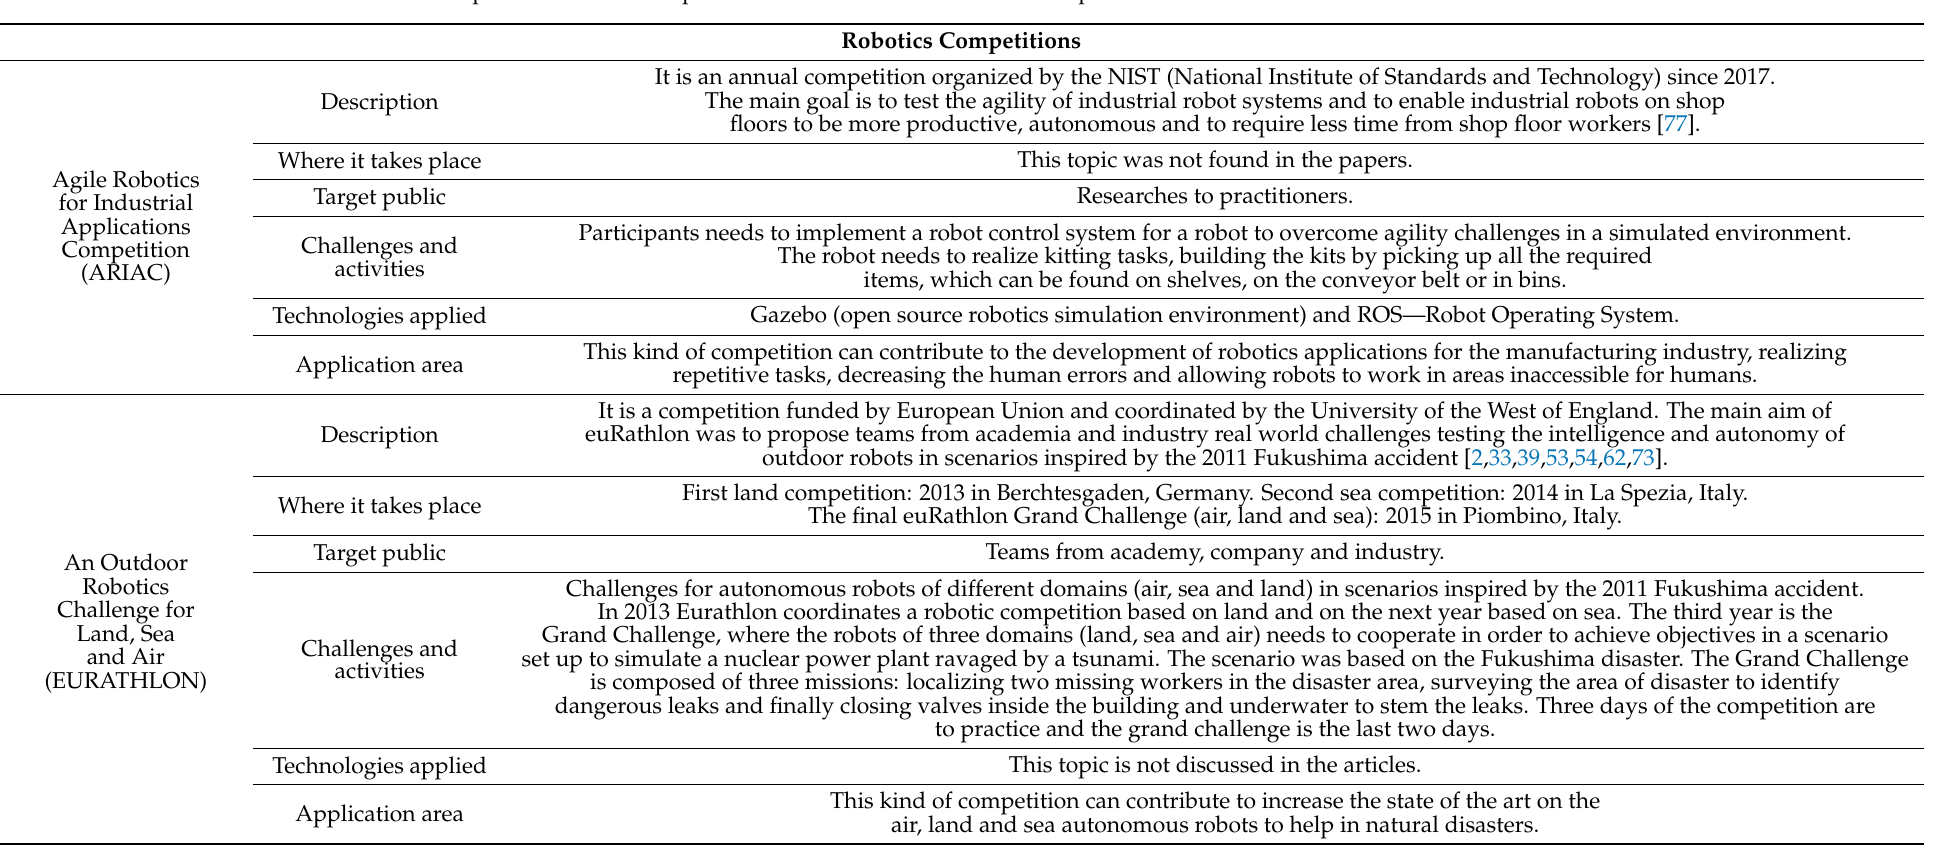
Table 4. Description of robotics competitions taken from the data extraction